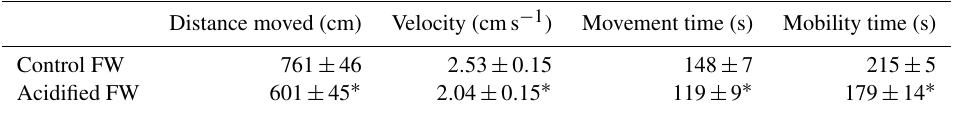
Table 3. Changes in locomotory behaviour of juvenile Chinese mitten crabs, Eriocheir sinensis , after a 7d exposure to control (pH 7.41, 1299µatm p CO 2 ) or CO 2 -acidified (pH 6.73, 5109µatm p CO 2 ) freshwater. Data are presented as mean ± SEM. ( N = 18–19). Statistical significance was assessed by Student’s t test or the Wilcoxon test for mobility time, with ∗ indicating significant difference between control and acidified FW treatments.